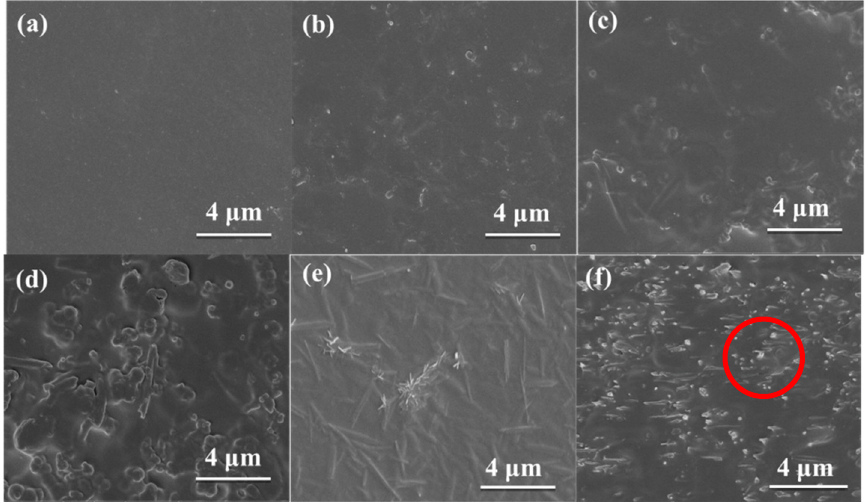
Figure 6. SEM images of MMMs with different loadings: ( a ) 0 wt.%; ( b ) 5 wt.%; ( c ) 10 wt.%; ( d ) 15 wt.%; ( e ) 20 wt.%, and; ( f ) cross-section image of 20 wt.% MMM.